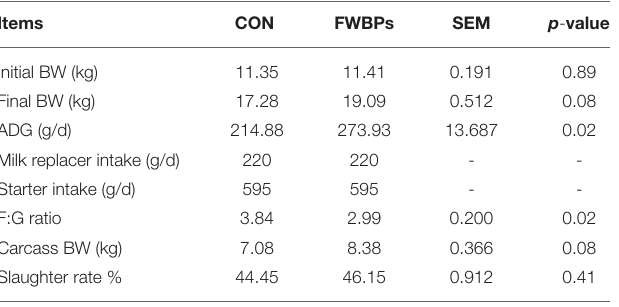
TABLE 2 | Effects of FWBPs on the growth performance of early-weaned lambs.